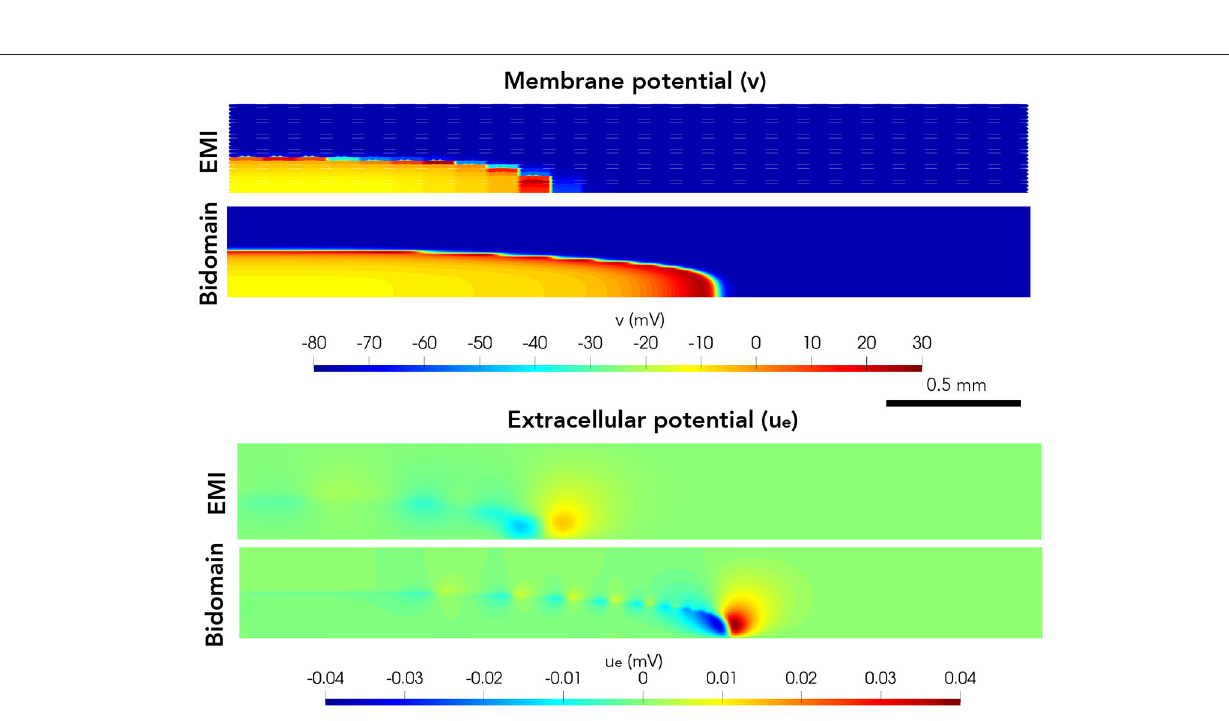
Frontiers in Physiology |